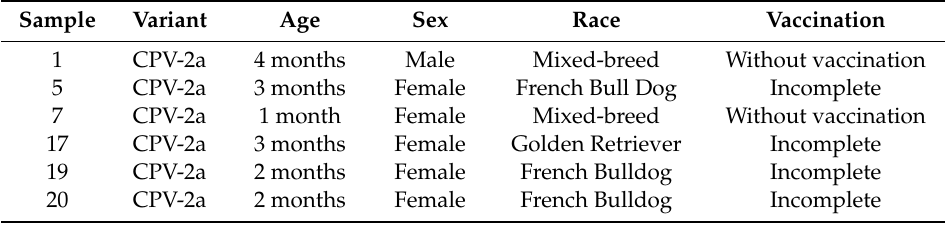
Table 1. Information on Canine Parvovirus (CPV-2)-positive samples included in the present study.